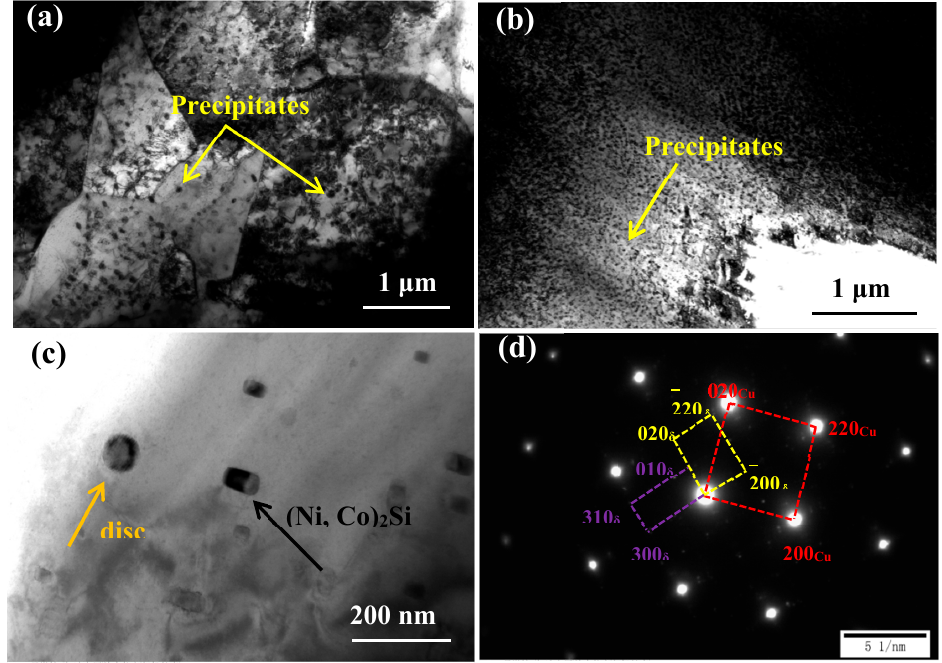
Figure 3. TEM micrographs of samples deformed at 700 °C and 0.01 s − 1 : ( a ) Cu-Ni-Co-Si-Cr; ( b ) and ( c ) Cu-Ni-Co-Si-Cr-Ce; ( d ) SADP of corresponding area in (c).